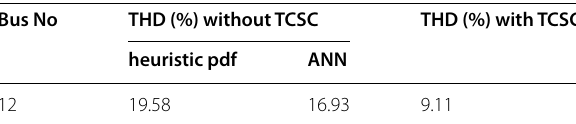
Table 21 THD of real power flow with and without TSC for IEEE 57 -bus system at bus 12